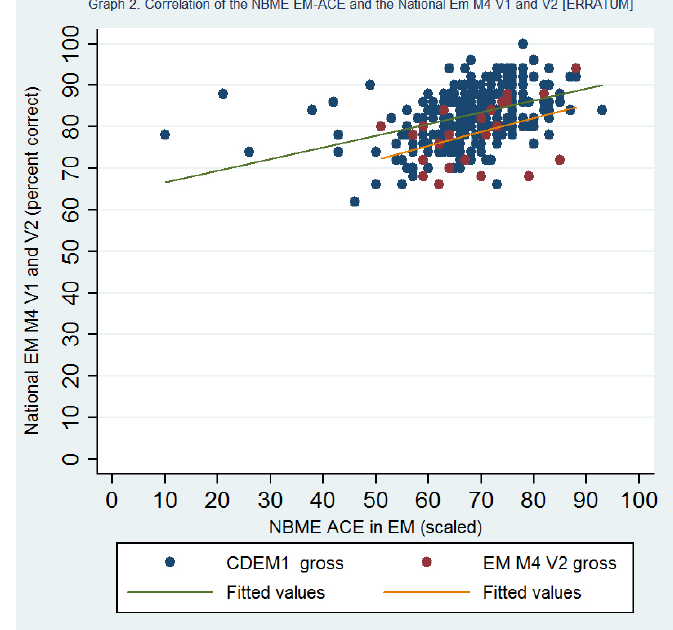
Figure 1. Correlation of NBME EM-ACE and National EM M4 V1 and V2.